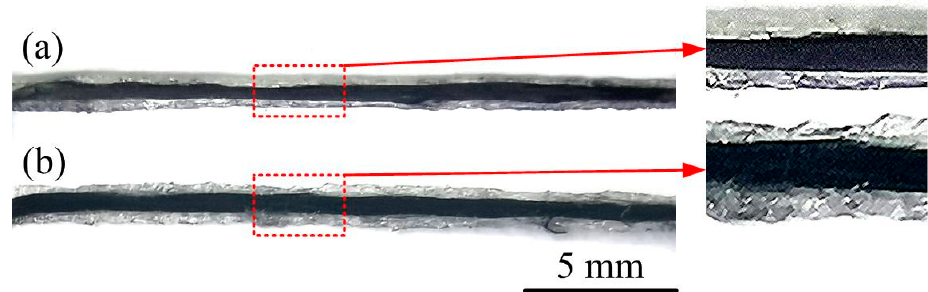
Figure 5. ( a ) Photograph of single channel forming path when the nozzle moving speed and wire feeding speed were both 5 mm/s; ( b ) the nozzle moving speed and wire feeding speed were both 10 mm/s. In the single channel composite forming process, the height of the nozzle from the substrate also had a significant impact on the single channel deposition path width and forming quality. Therefore, we set the wire feed speed and nozzle moving speed at 5 mm/s and tested different nozzle height conditions in single-pass forming experiments. Figure 6 shows the resulting experimental data and forming paths.